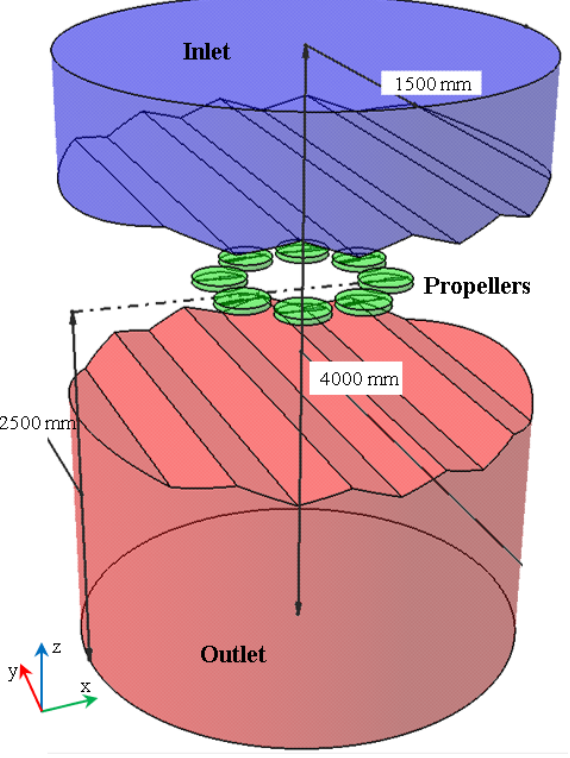
Figure 5. This figure shows the CFD–LPT domain. Air and parti- cles enter the domain at the top of the blue section labelled “Inlet” and flow downwards past the propellers. Each of the propellers is in a small green cylinder representing the overset mesh region; a section of the cylinder is cut away here for illustration purposes. Air and particles leave the domain through the bottom face of the cylinder in the red region.